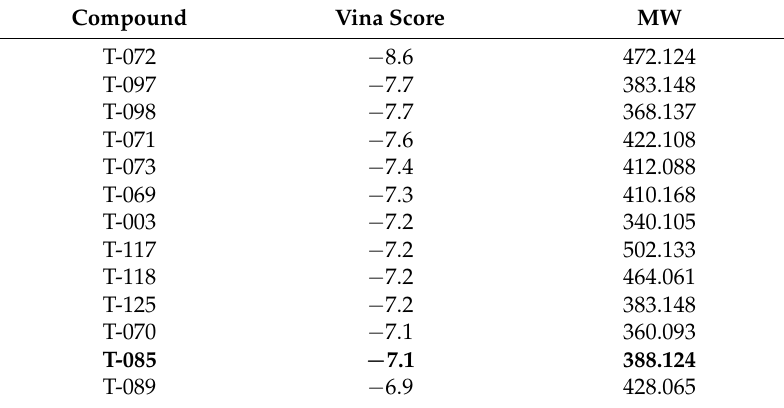
Figure 2. Structure of quinoxaline-7-carboxylate derivatives tested as TR inhibitors. T-003 , T-021 and T-044 were previously reported with trypanocidal activity by Villalobos-Rocha et al.